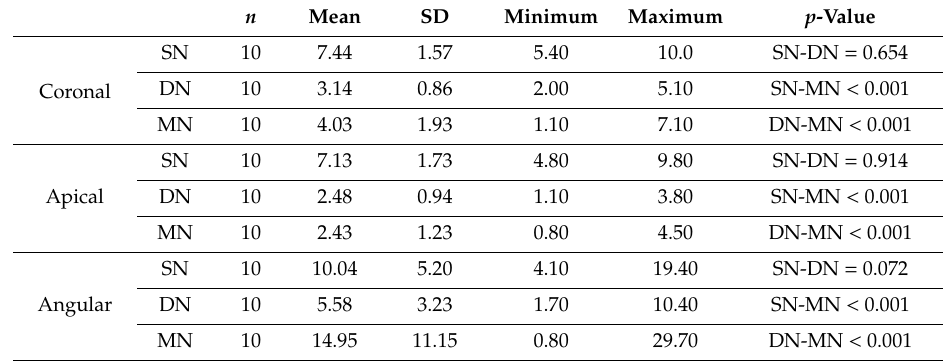
Table 1. Descriptive deviation values at coronal (mm), apical (mm), and angular ( ◦ ) levels and statistical significance ( p -value).